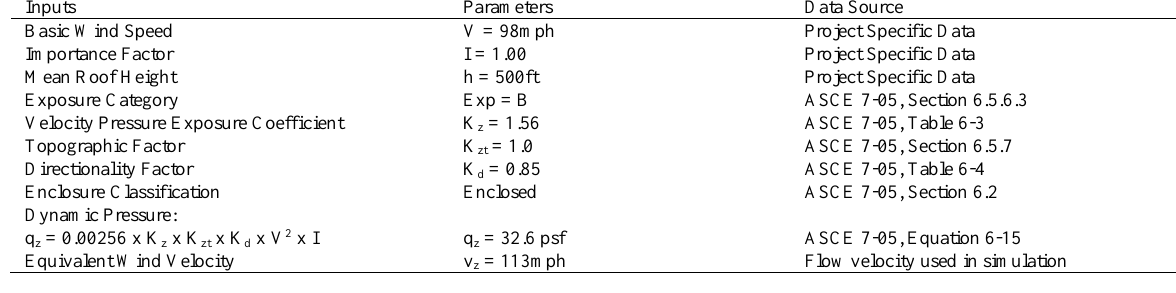
Table 1: Calculation input parameters